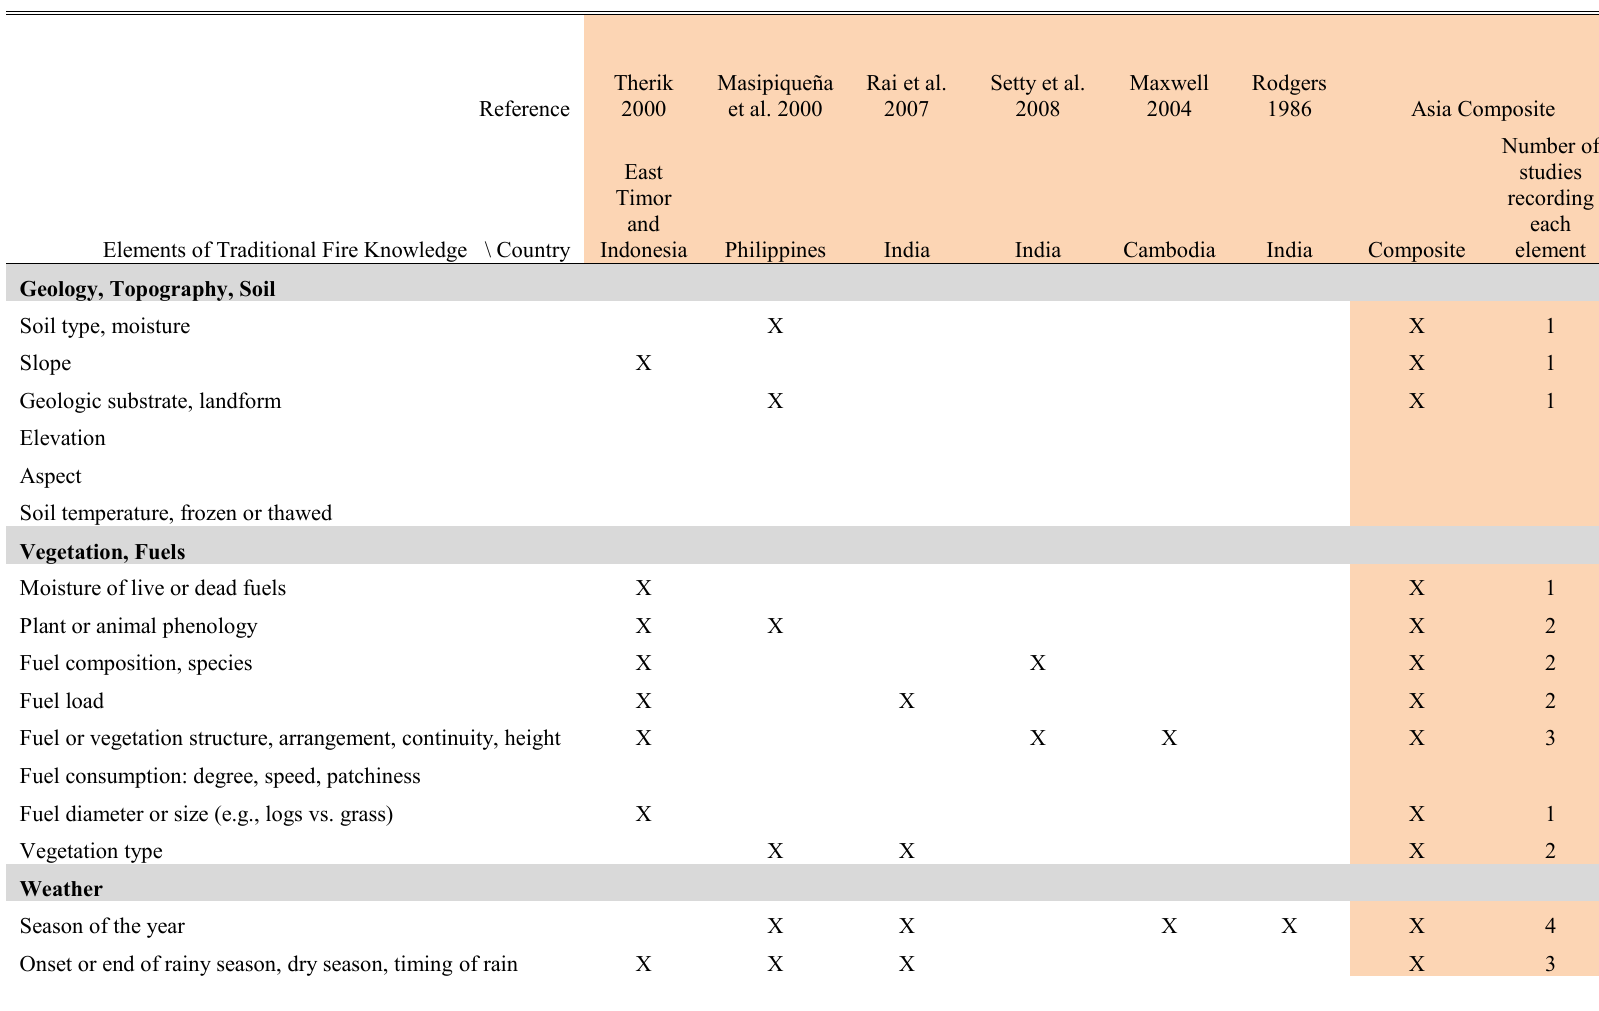
Table A.2. Elements of traditional fire knowledge recorded in studies from Asia